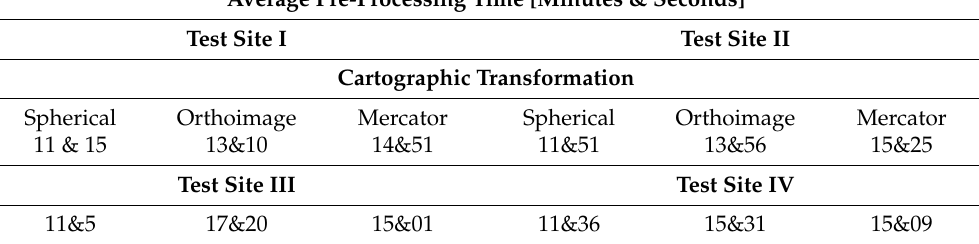
Table 1. The pre-processing data